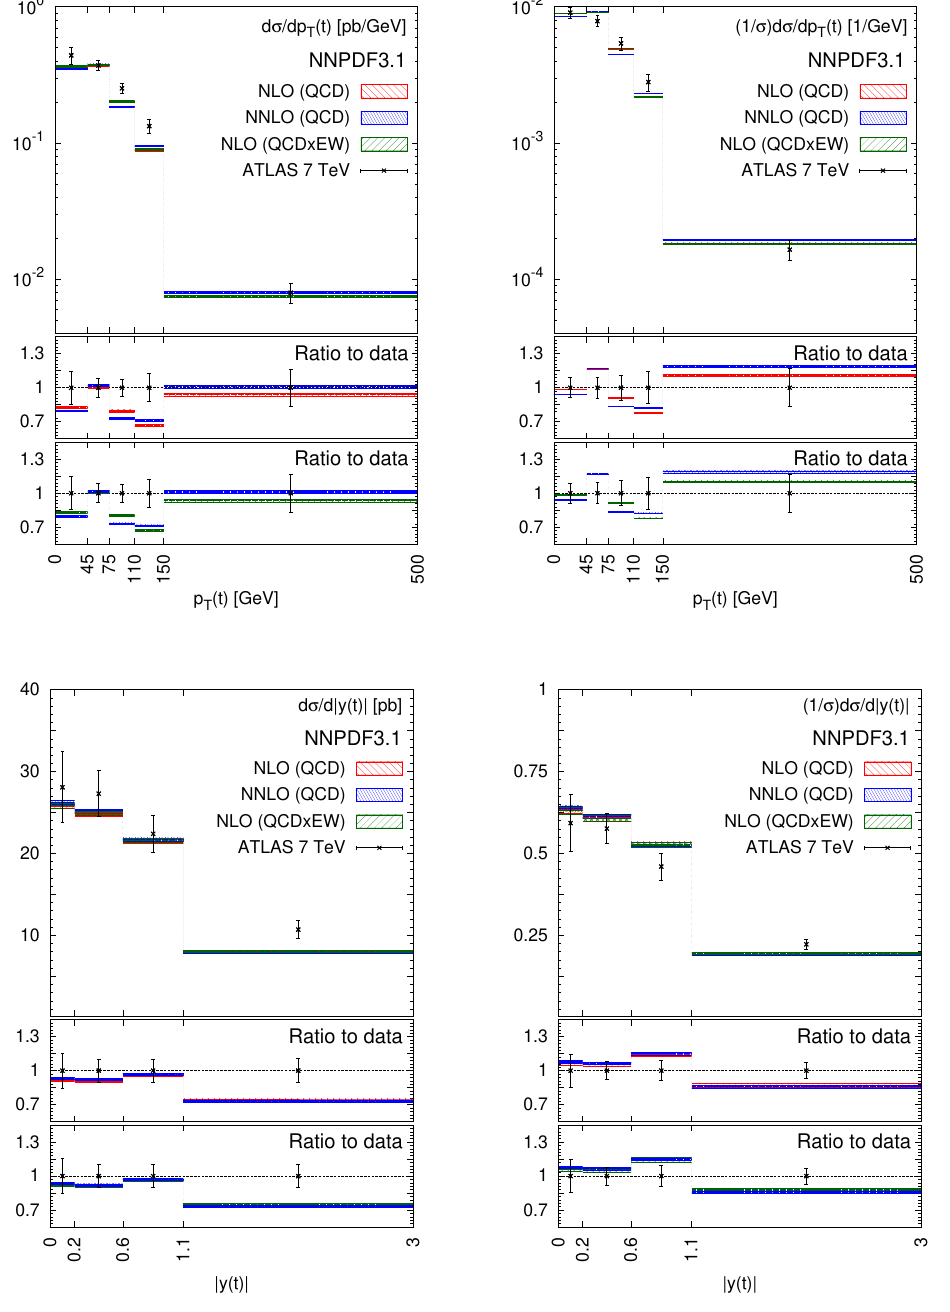
Figure 3 . The t -channel single top-quark absolute (left) and normalised (right) cross sections from ATLAS analysed in this work (see table 2). The measurements are compared to theoretical predictions computed as in (cid:12)gure 2. The two lower panels display the data and the theoretical predictions normalised to the central value of the data.